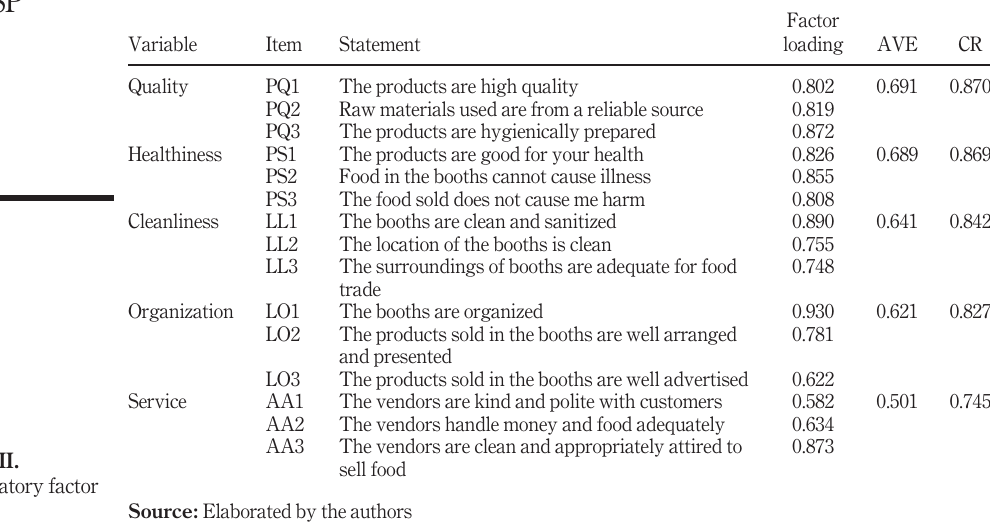
Table III. Con fi rmatory factor analysis